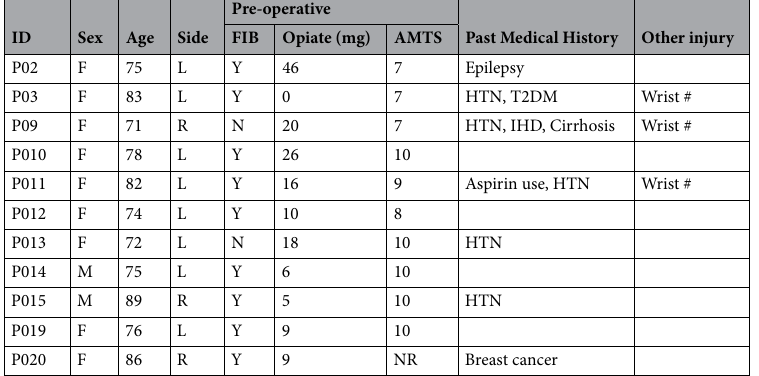
CSF adjusted- p value Friedman test